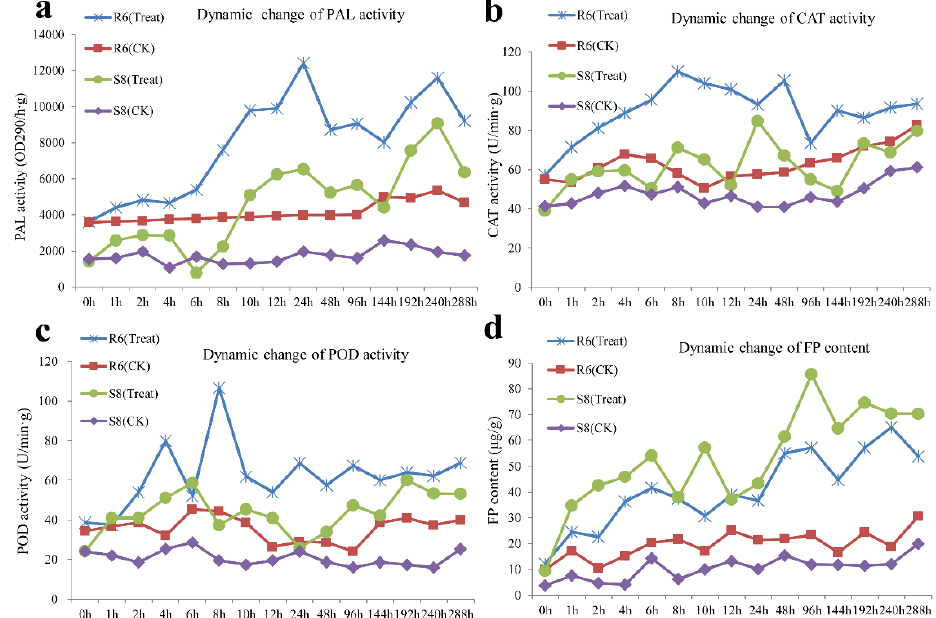
Figure 2. Determination of PAL ( a ), CAT ( b ) and POD ( c ) enzyme activity and FP ( d ) content in maize leaves in response to C. zeina . The x axis represents infection at different times after inoculation. Maize inbred lines differing in GLS resistance (R6 = resistant and S8 = sensitive) were inoculated with C. zeina (Treat) or not (CK).